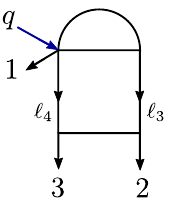
Figure 5 . Integral topology that cannot be detected by the two-particle s 23 -channel